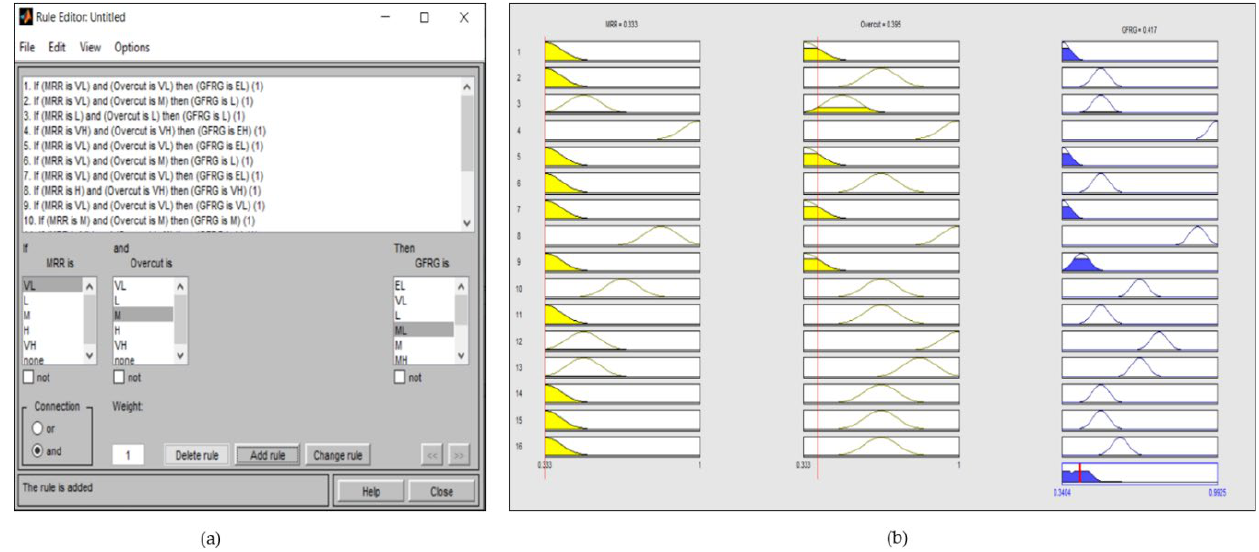
Figure 9. Pictorial illustration of elaborated rules. ( a ) Rule editor for the EDM process. ( b ) Rule viewer for the EDM process.